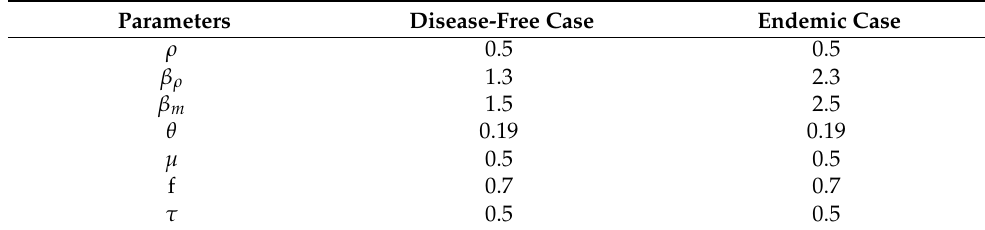
Table 1. Parameters used for simulation